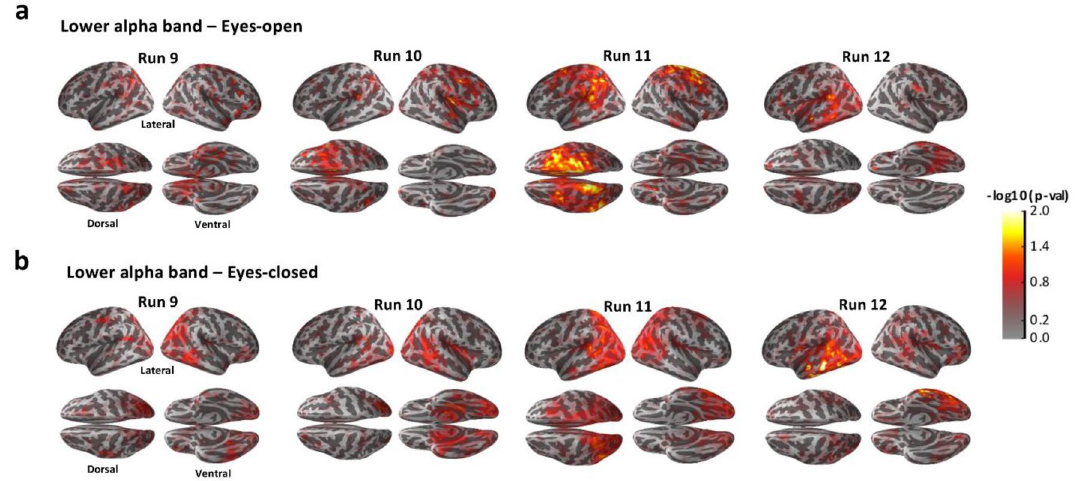
Figure 3. p value maps of one-way ANOVA on MEG baseline-corrected lower alpha band power spectral density of RF-EMF post-exposure sessions (real vs. sham) at source level analysis during eyes-open recordings ( a ) and eyes-closed recordings ( b ). p values were computed for each MEG source location (4098 current dipoles per hemisphere) for 29 subjects ( p < 0.05). The cortex is shown inflated with gyri darker than sulci, with lateral (left and right), dorsal and ventral visualizations.